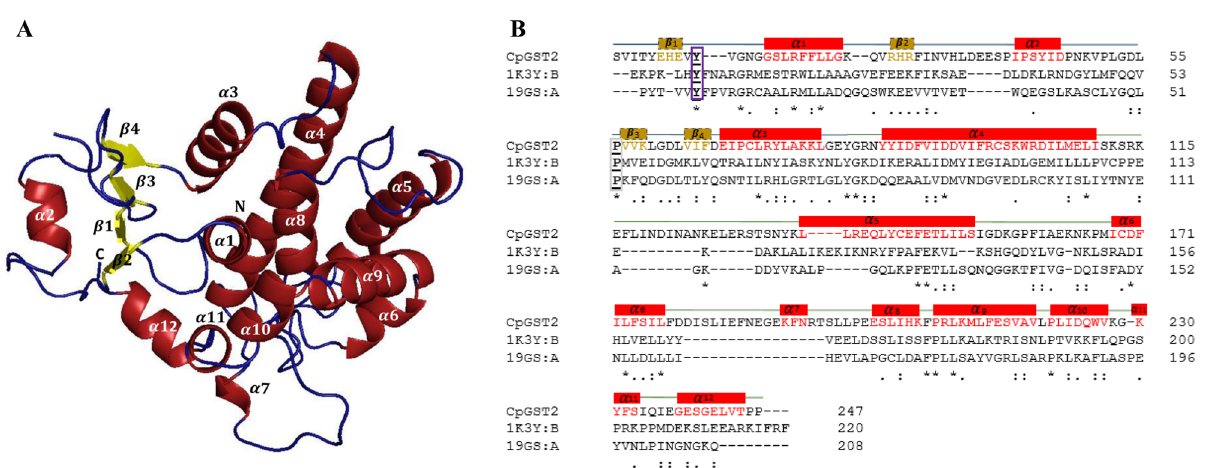
Figure 4. In silico structural analysis of Gamma class representative Cryptosporidium parvum glutathione transferase 2 (C p GST2). 3D model of C p GST2 ( A ) and its amino acid sequence alignment with templates ( B ). Secondary structural annotations were done as per modeled structure where α-helices and corresponding amino acids are colored in red while the β-sheets and their corresponding amino acids are colored in yellow. The active-site tyrosine and the cis -proline residues are boxed in purple and grey respectively. The template Protein Data Bank codes, 1K3Y-B and 19GS-A, represents GST protein crystal structures of Alpha class (1K3Y-B) and Pi class (19GS-A) GSTs from